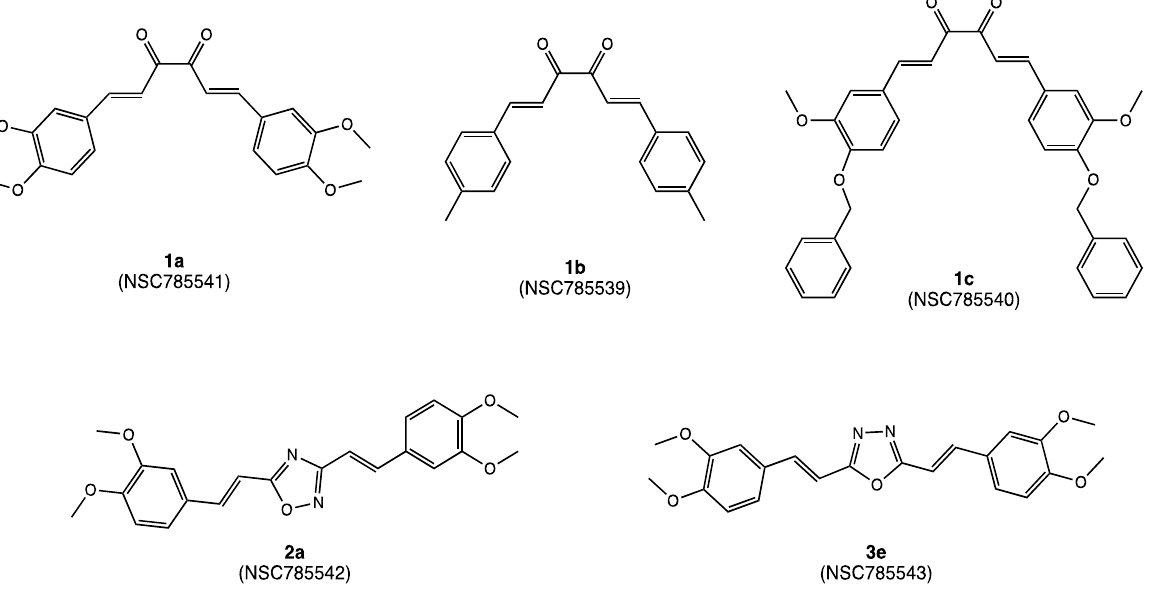
Figure 8. Chemical structures of the five curcumin-like compounds selected by NCI for the one-dose antiproliferative assay.